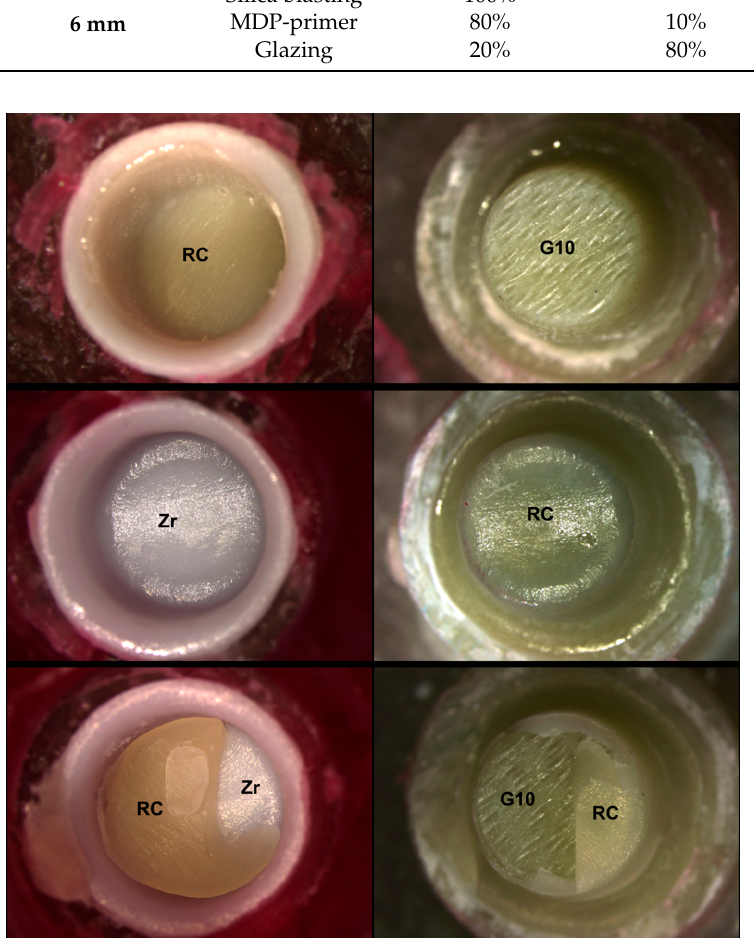
Figure 4. Stereomicroscope images–10 × objective. On the right side are the G10 preparations, and the copings made from zirconia are on the left side. The first row shows a “G10 adhesive failure”, where the resin cement (RC) is on zirconia coping. In contrast, the second row shows a “zirconia adhesive failure” pattern, where the resin cement is on the G10 surface. The third row presents a “mixed (cohesive and adhesive) failure”, where resin cement can be observed on both surfaces (zirconia coping and G10 substrate).